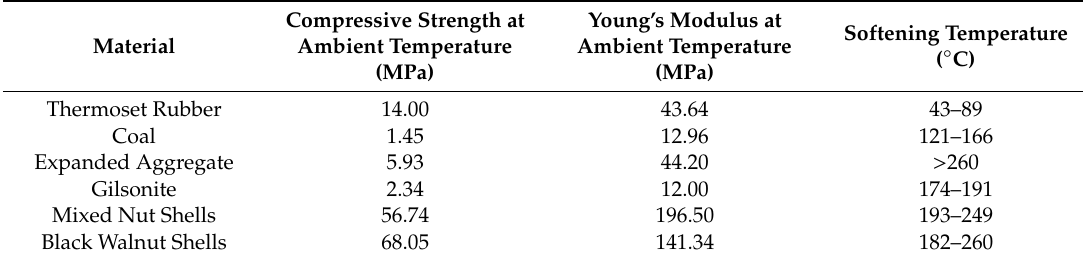
Table 2. Granular material properties and softening temperatures